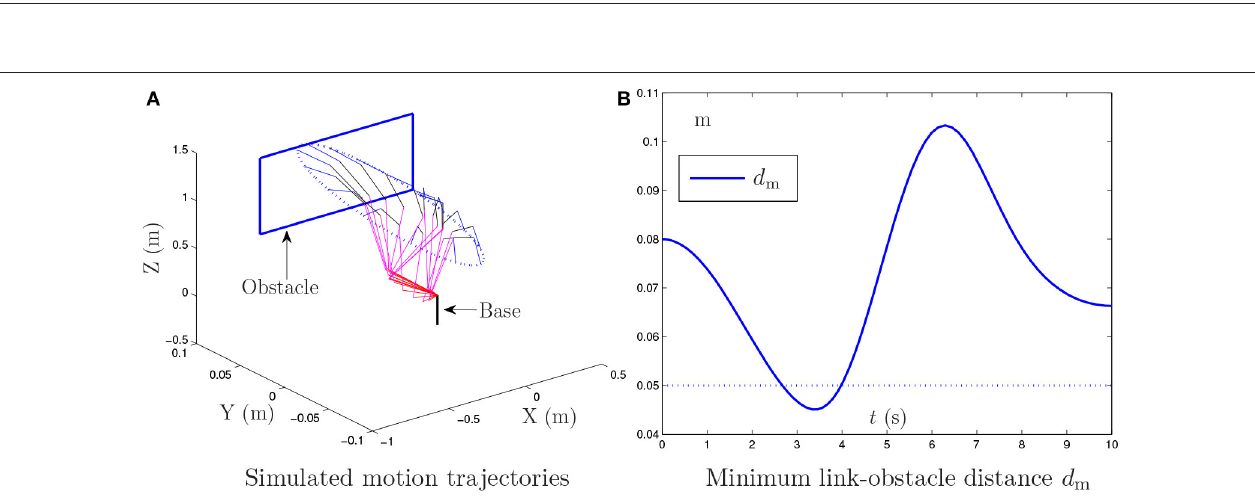
Frontiers in Neurorobotics | www.frontiersin.org